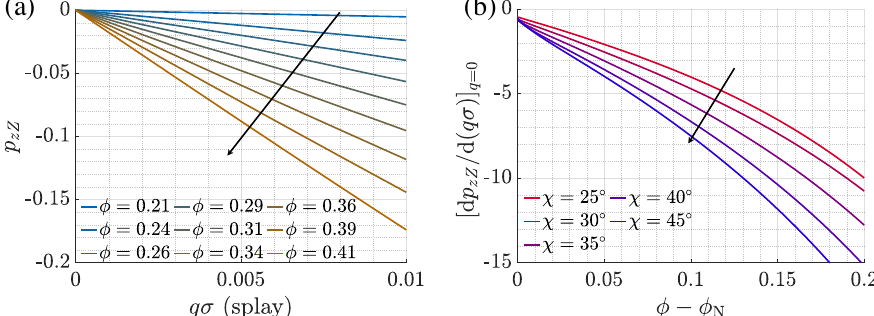
Figure 4. ( a ) Polar longitudinal order parameter p zZ for V-shaped particles with bend angle χ = 45 ◦ in the presence of a splay deformation, as a function of the deformation wavenumber q , at different values of the packing fraction φ . ( b ) Slope of the longitudinal polar order parameter induced by a splay deformation, p zZ ( q ) , calculated at q = 0, as a function of the volume fraction difference φ − φ N , for acute angle V-shaped particles with different values of the bend angle. φ N is the packing fraction in the nematic phase at the nematic-isotropic boundary. Negative p zZ values mean that the apex of a V-shaped particle preferentially points towards the center of the splay deformation (see Figure 1).